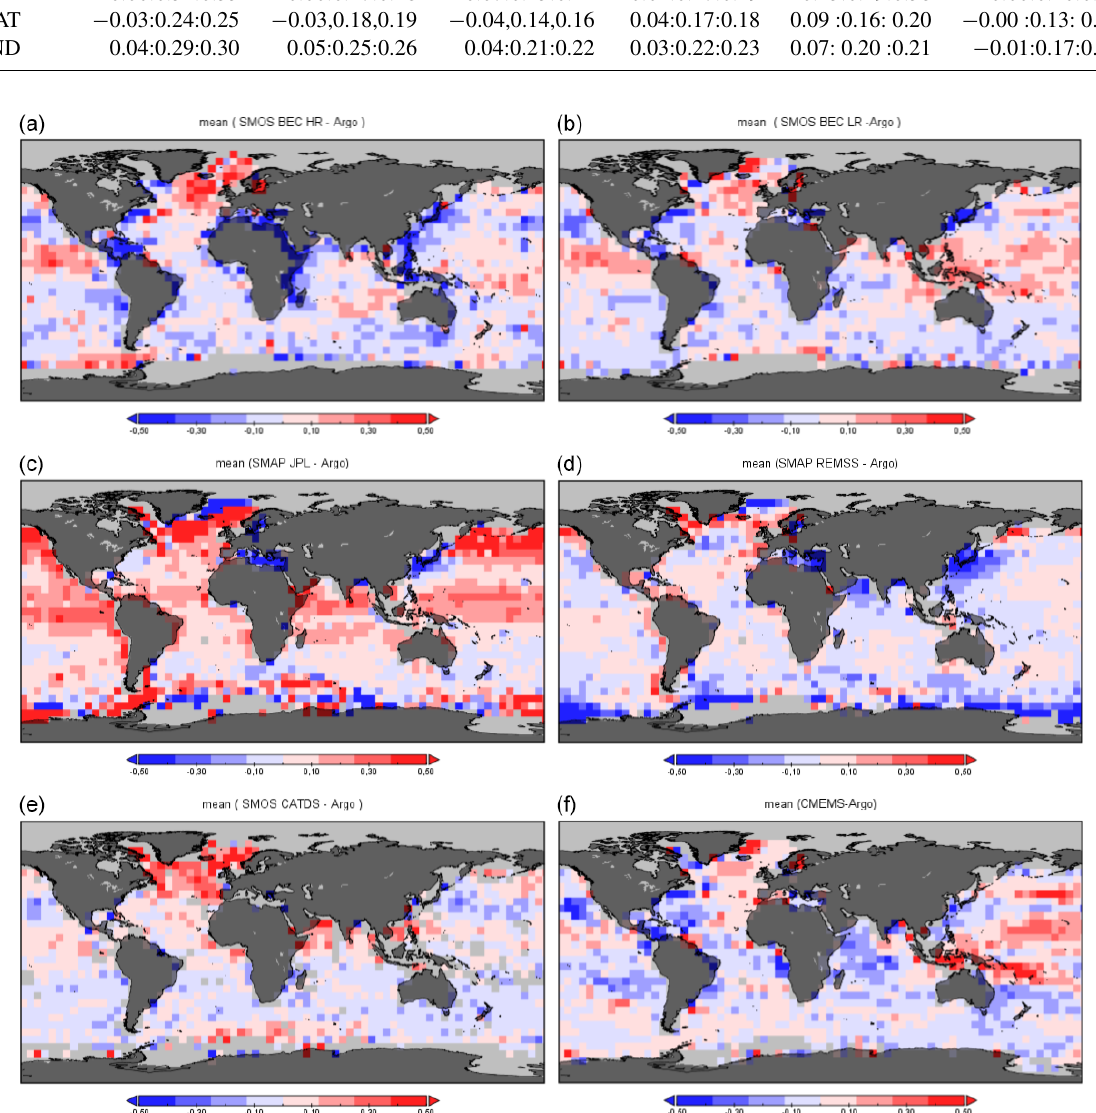
Figure 6. Spatial distribution of the mean differences with respect to Argo SSS. From left to right and top to bottom: BEC HR, BEC LR, JPL, REMSS, CATDS, and